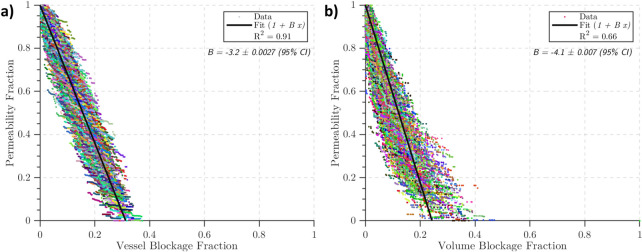
The drops in permeability over 500 statistically accurate capillary networks with a cube length of 375 μm.Lines of best fit are in black, with the gradient B in the top right corner of each graph. a) The fractional drop in permeability with fraction of vessels occluded (B = −3.2), b) the fractional drop in permeability with vessel volume occluded (B = −4.1).